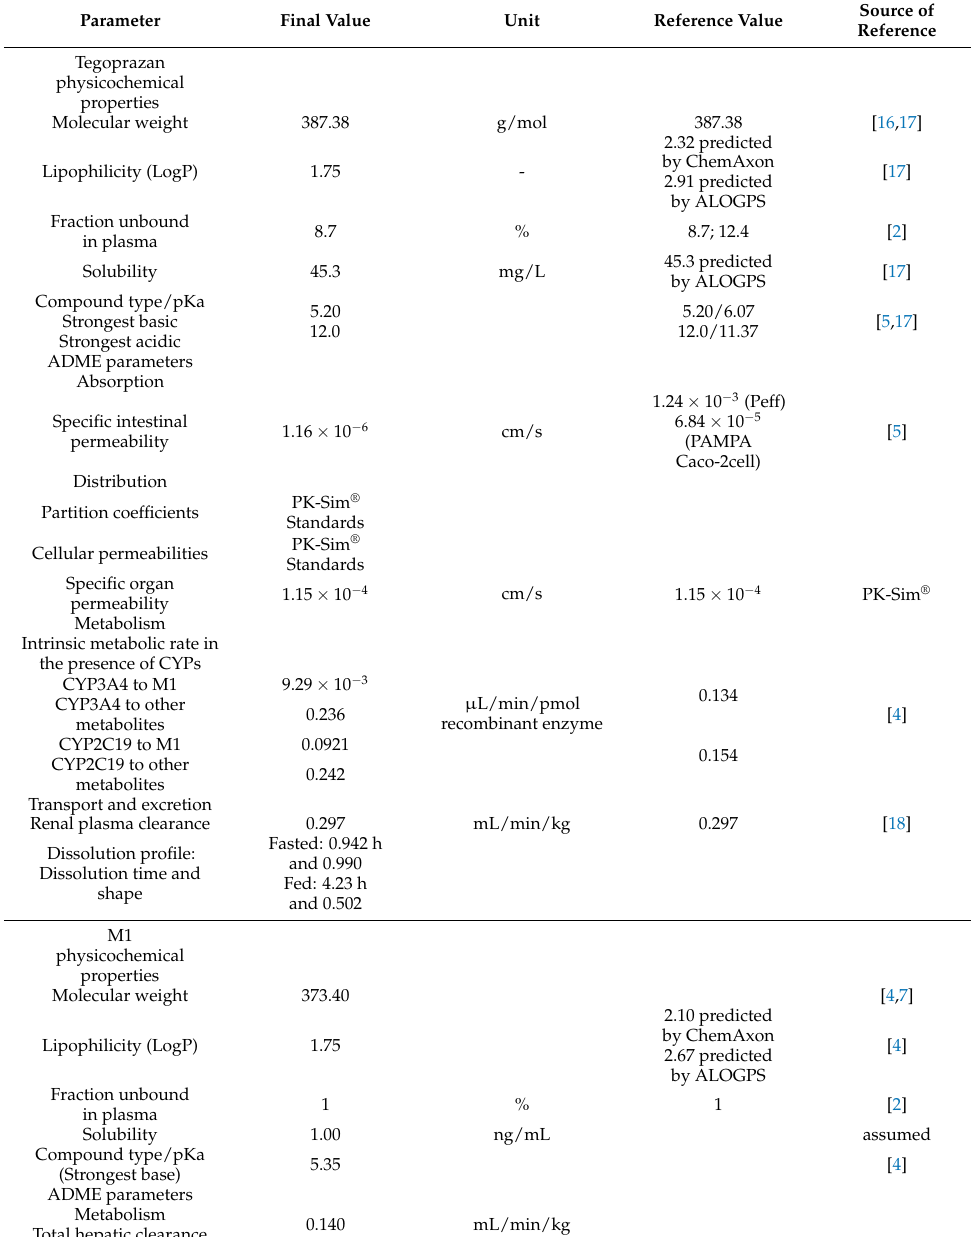
Table 1. Input parameters and optimized parameters for the PBPK model of tegoprazan and the metabolite